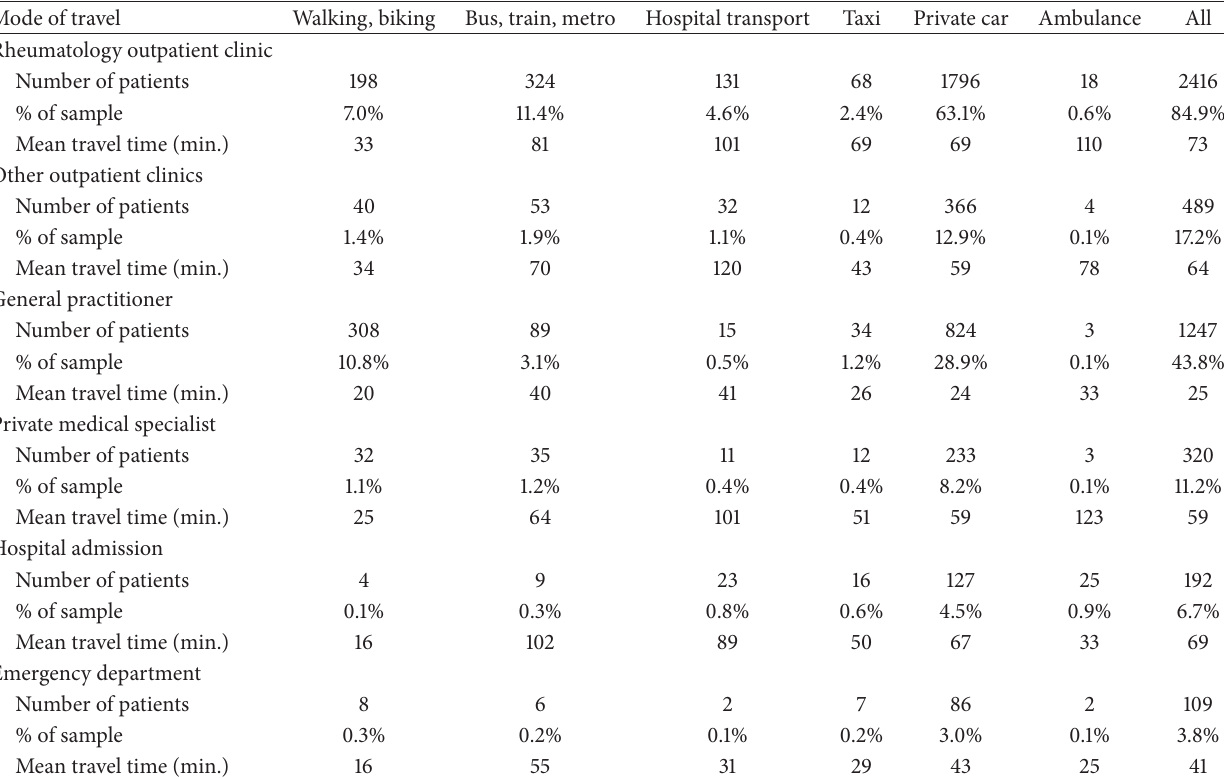
Table 3: Mode of travel and mean (return) travel time to different health care providers as reported by patients with rheumatoid arthritis. Mode of